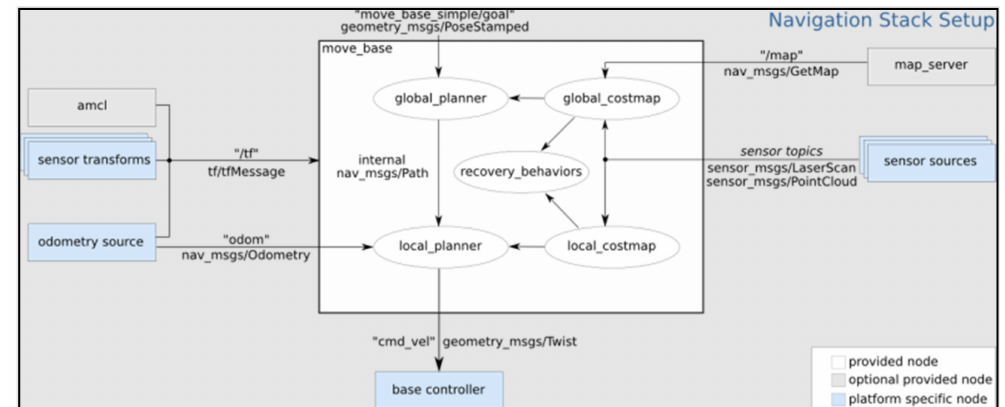
Figure 6. ROS navigation stack setup [95].